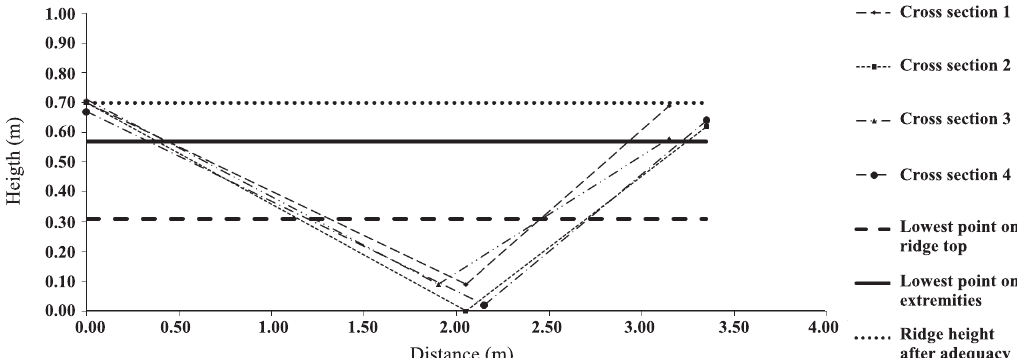
figure 3. cross section profile of the channel of terrace